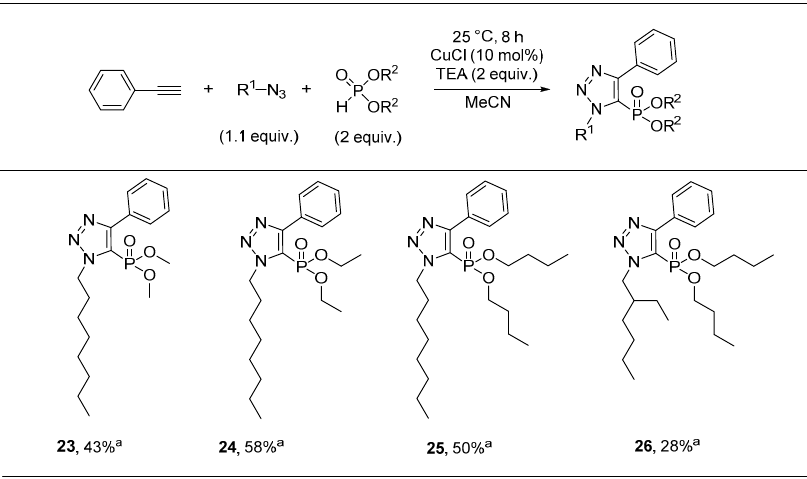
Table 3. Summary of biological activity measurements.